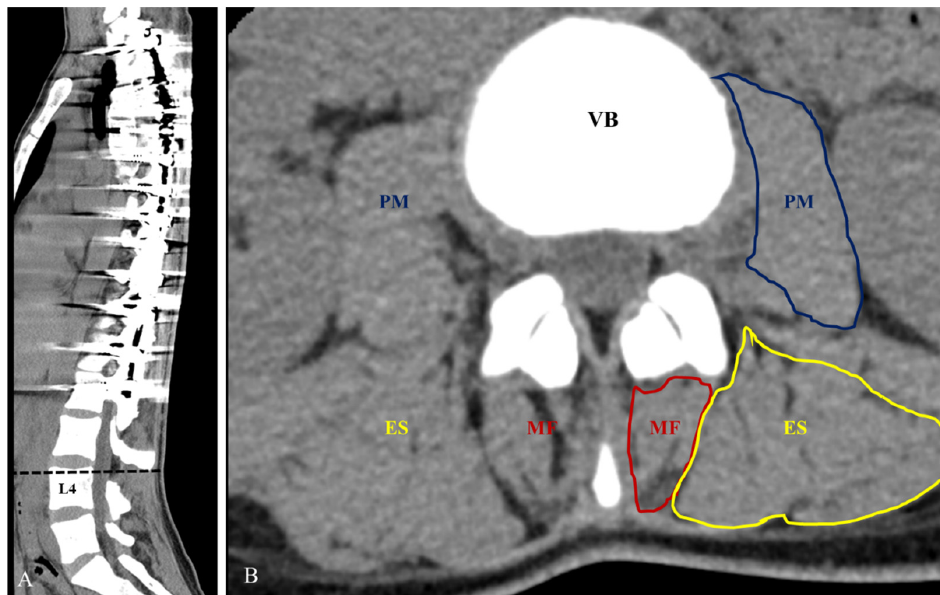
Figure 1. The cross-sectional areas (CSAs) of individual paraspinal muscles (multifidus (MF), erectus spine (ES), and psoas major (PM) muscles), and L4 vertebrae body (VB) were measured by assessment of axial computed tomography (CT) images. Measurements of the CSA of the paraspinal muscles were obtained at the level of the upper endplate of L4 by manual tracing ( A , B ).